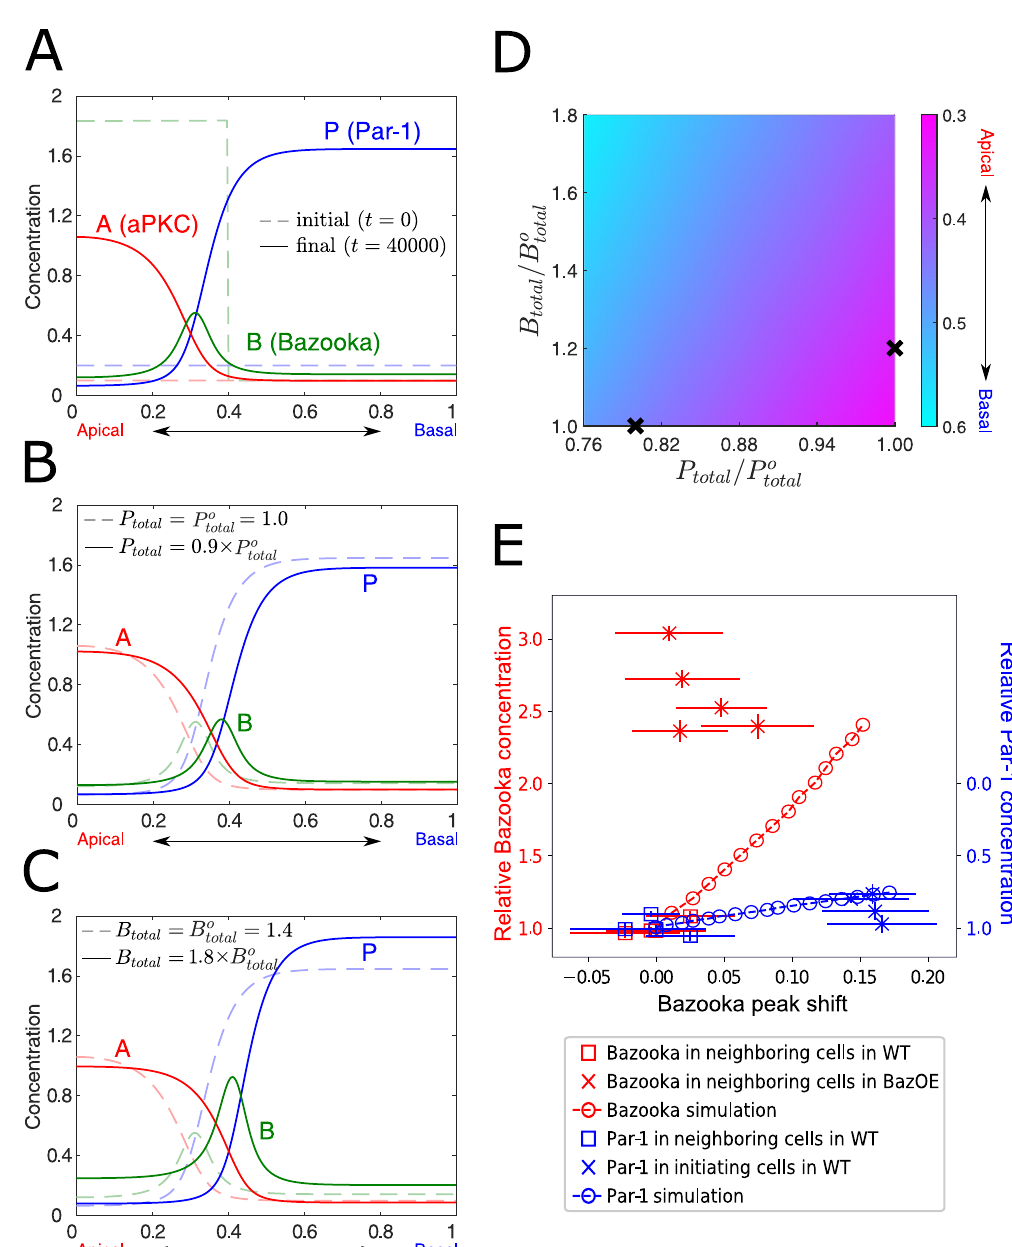
Fig 2. The “ A – B – P network” model recapitulates the spatial profile of apical–basal polarity formation and remodeling in the Drosophila cellular blastoderm. (A) The initial and final steady-state distributions of polarity regulators in the model. The membrane location is scaled by L and hereafter. (B, C) Basal shifts of the Bazooka peak position at the steady state (solid line) following a decrease in P (B) or an increase in B (C) as compared to the steady-state profile (dashed line) in (A). total total (D) Color plot of the Bazooka peak positions as a function of fold change of P total and B total . The crosses are for the comparison between Bazooka peak positions with a 20% perturbation of P decrease and B increase. (E) Bazooka peak total total position shift in response to Par-1 down-regulation (blue, y-axis right) or Bazooka overexpression (red, y-axis left) in experiments (squares and crosses with error bars both in the x- and y-axis) and simulations (circles with a dashed line). Each experimental datapoint represents the mean measurement from one embryo. Error bars are standard deviations of sample sizes n = 20–30 for the initiating cells or n = 70–100 for the neighboring cells. See Materials and methods for details on experimental measurements.